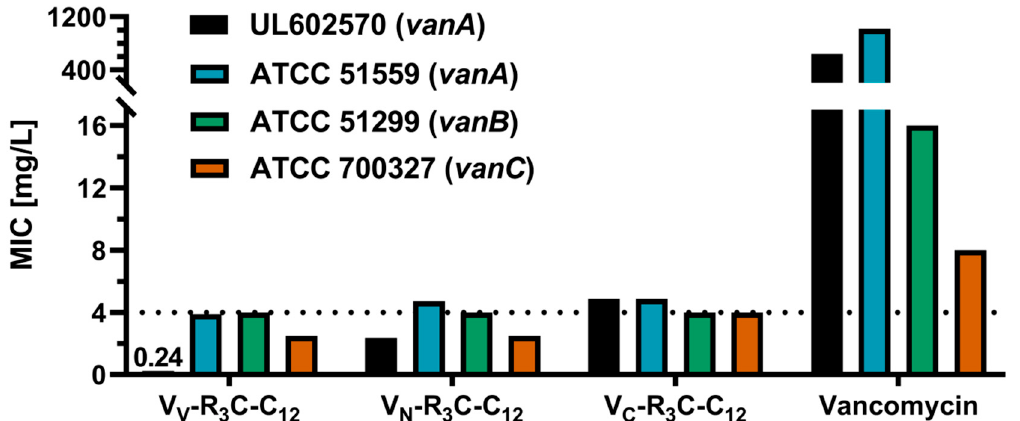
Figure 3. Comparison of MIC values for vanA, vanB, and vanC resistant enterococci. The tested conjugates were modified with the same lipopeptide, but coupled on varying modification sites. The different MIC values demonstrate the influence of the modification position. The dotted line denotes the enterococci resistance breakpoint of 4 mg/L. Data are shown as the median of a minimum of three independent experiments tested at least in duplicate. A tabular overview is shown in the supplementary information, Table S2.